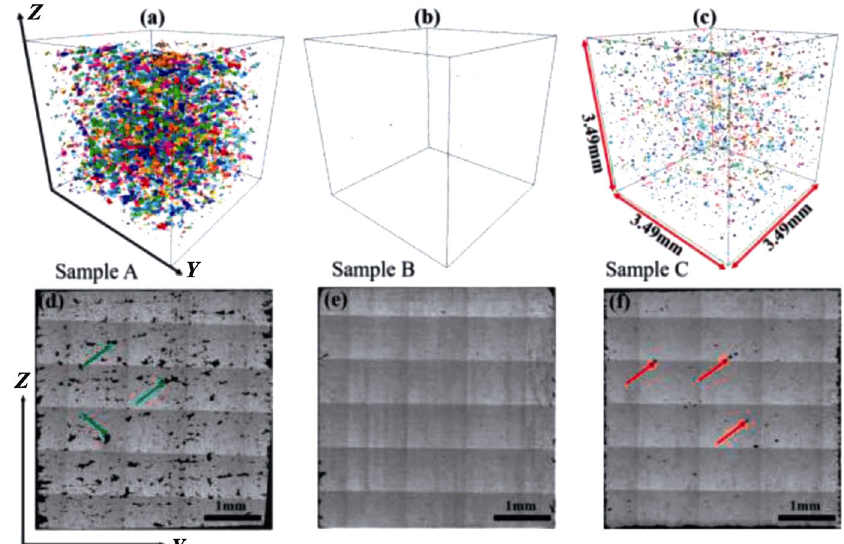
Fig. 38 XCT analysis of different additive manufactured materials. Reproduced with permission from Ref. [104], © Elsevier